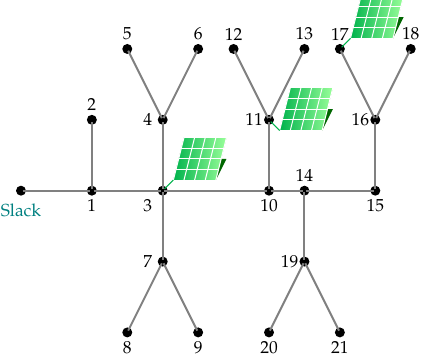
Figure 1. Single diagram of the modified 21-bus bipolar DC